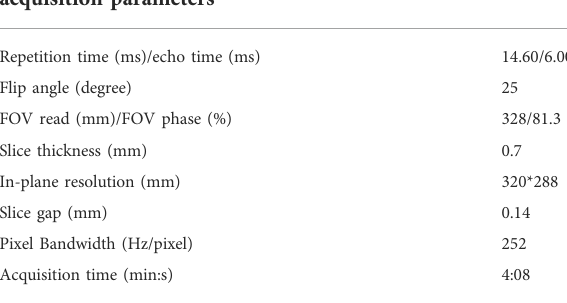
TABLE 2 Imaging parameters of 3D-DESS sequences. Imaging acquisition